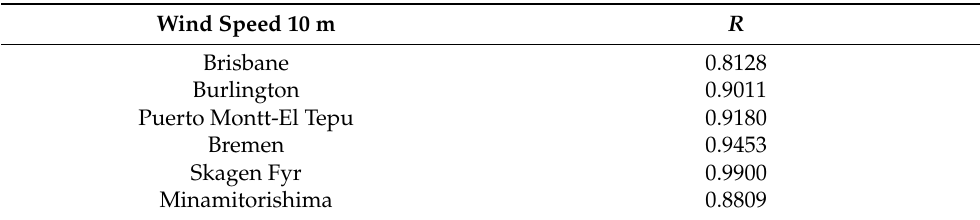
Table 7. Correlation coefficients of monthly average values of wind speed at a height of 10 m through years